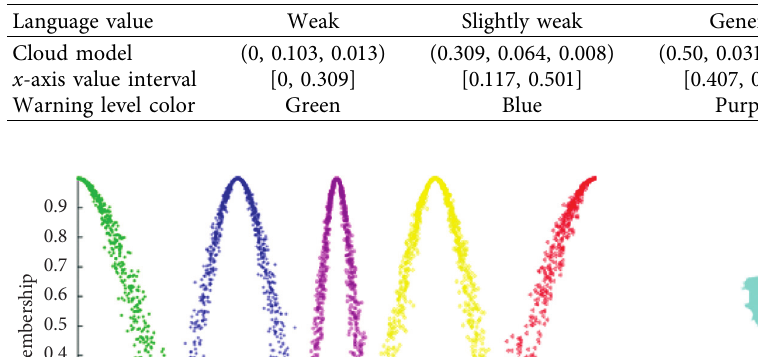
Table 4: Five standard comment sets.